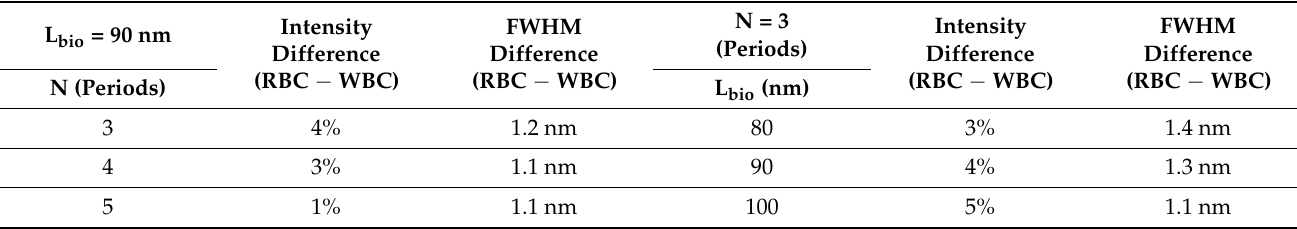
Table 1. Difference between the intensity amount and FWHM values of the RBC and WBC samples at different values of the period number for L bio = 90 nm and different values of L bio at a fixed number of 3 periods. L bio = 90